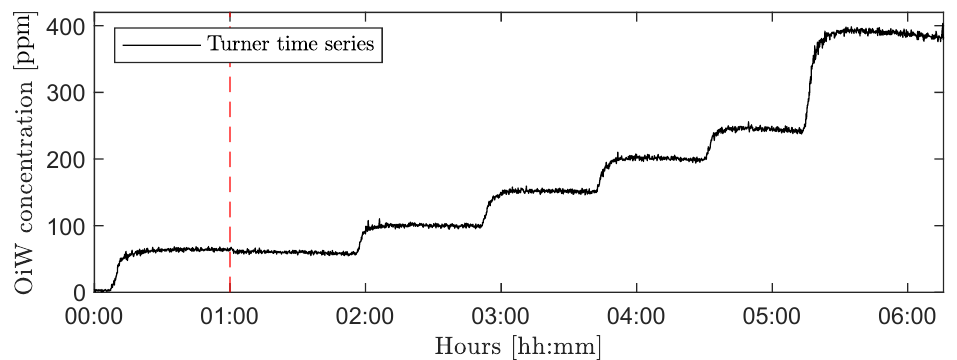
Figure 12. Time series of measured OiW concentration measured by C 1 executed on the setup shown in Figure 2. The vertical line marks the truncated time series of ∼ 3.5 h.